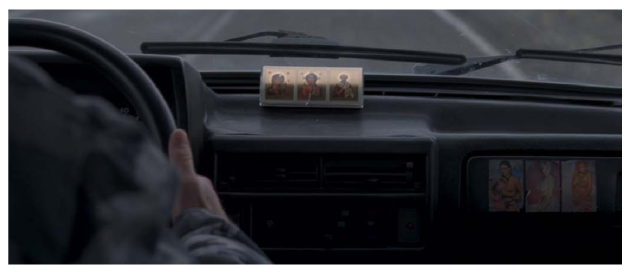
Figure 10. Leviathan (2014). Religions 2016 , 7 , 82